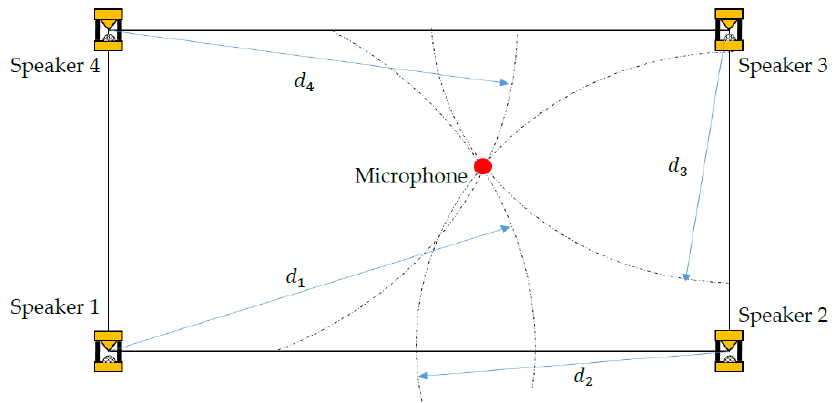
Figure 3. Basic setup of Spread Spectrum Sound-based Local Positioning System (SSSLPS).